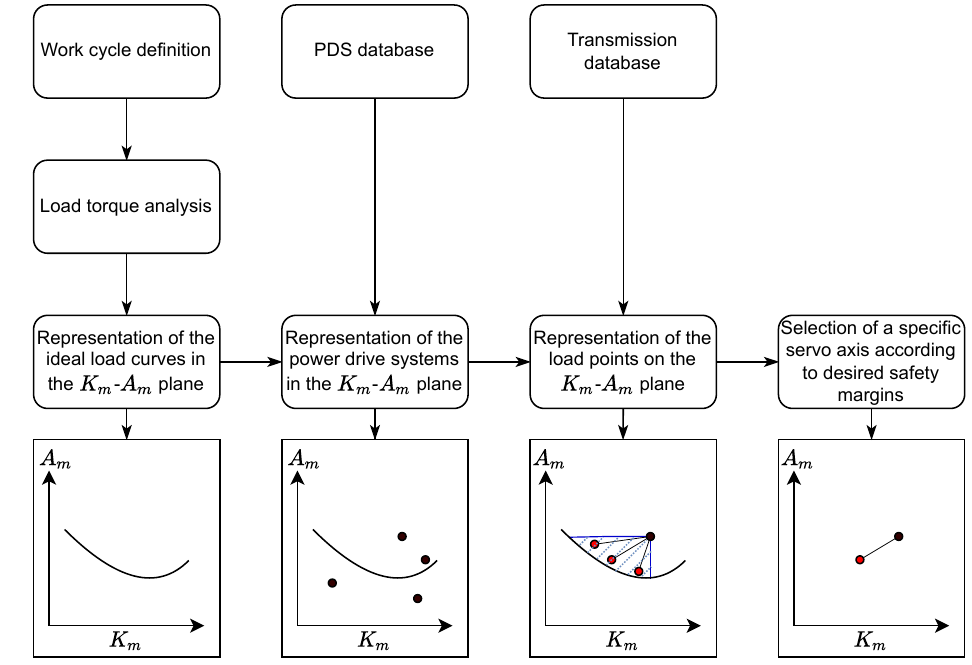
Figure 4. Selection flowchart for the servo